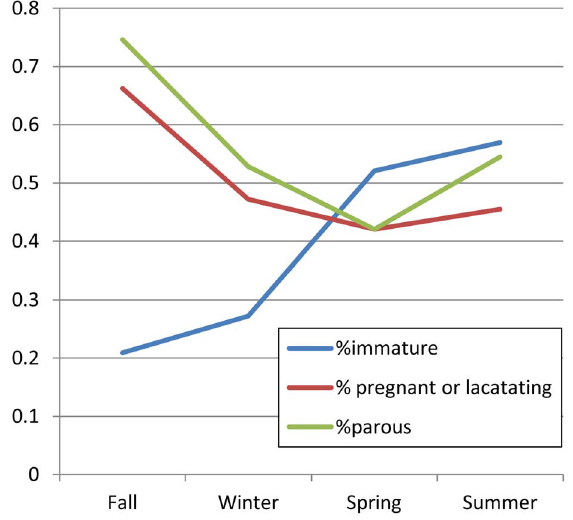
Figure 2. Seasonal variation in the proportion of immature, parous, and pregnant/lactating Norway rats ( Rattusnorvegicus ).